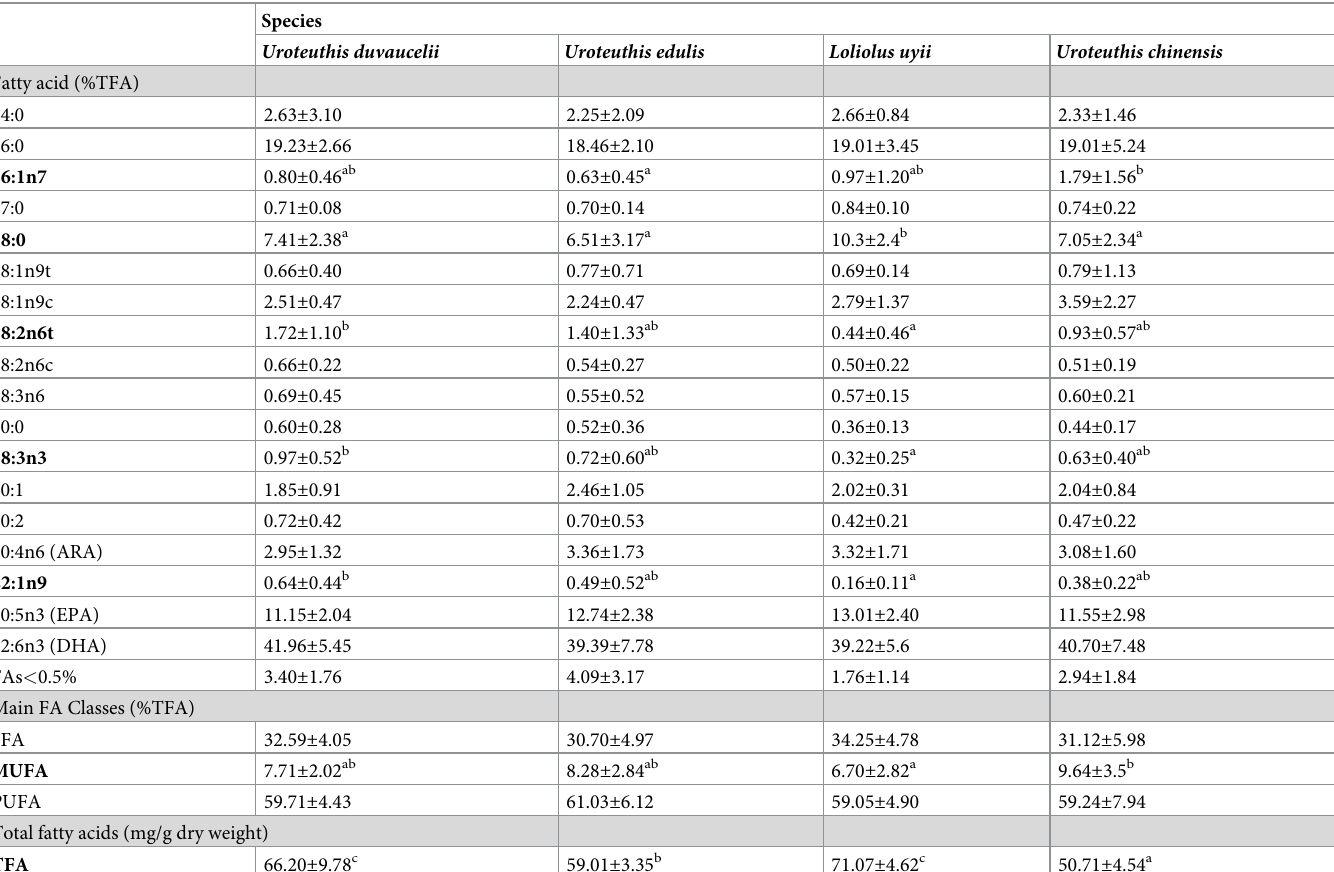
Table 3. Relative abundance of fatty acids for Uroteuthis duvaucelii , Uroteuthis edulis , Loliolus uyii , Uroteuthis chinensis in northern South China Sea.